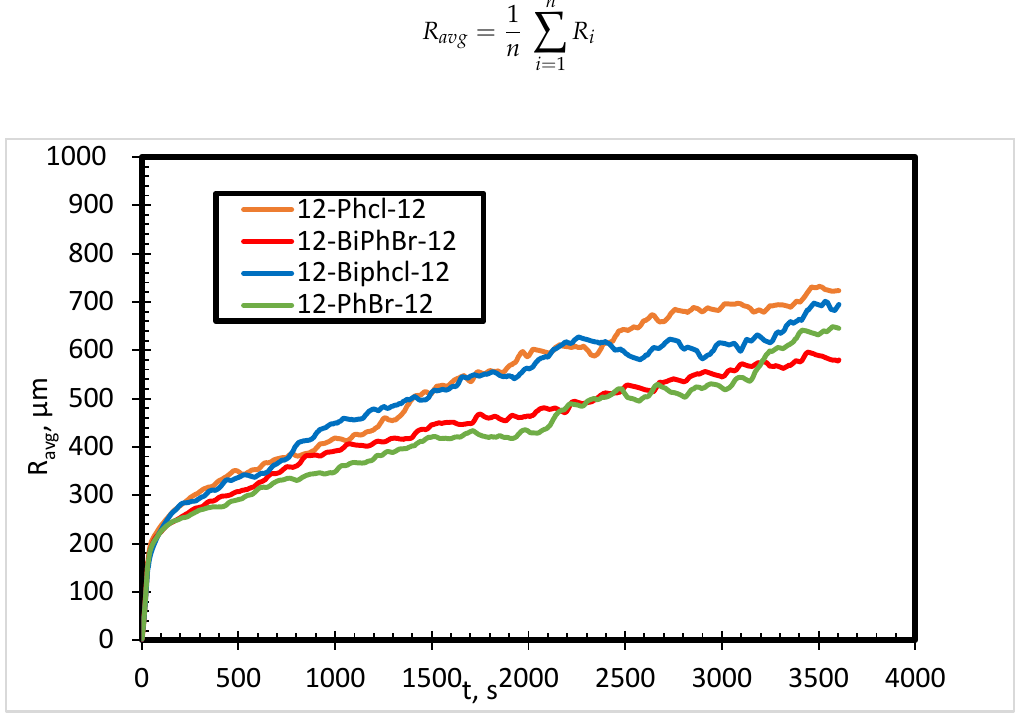
Figure 4. Effect of counterions with mono and biphenyl rings in deionized water on average bubble Figure 4. E ff ect of counterions with mono and biphenyl rings in deionized water on average radius. bubble